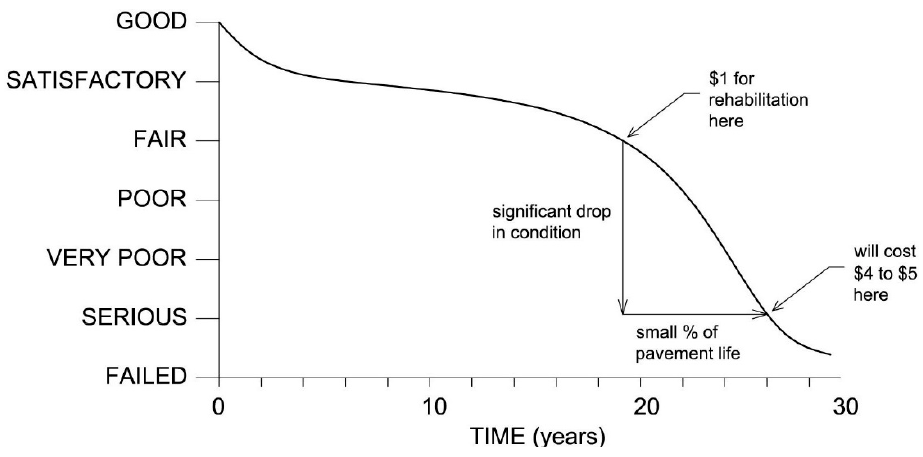
Figure 1. Schematic pavement life time [7].